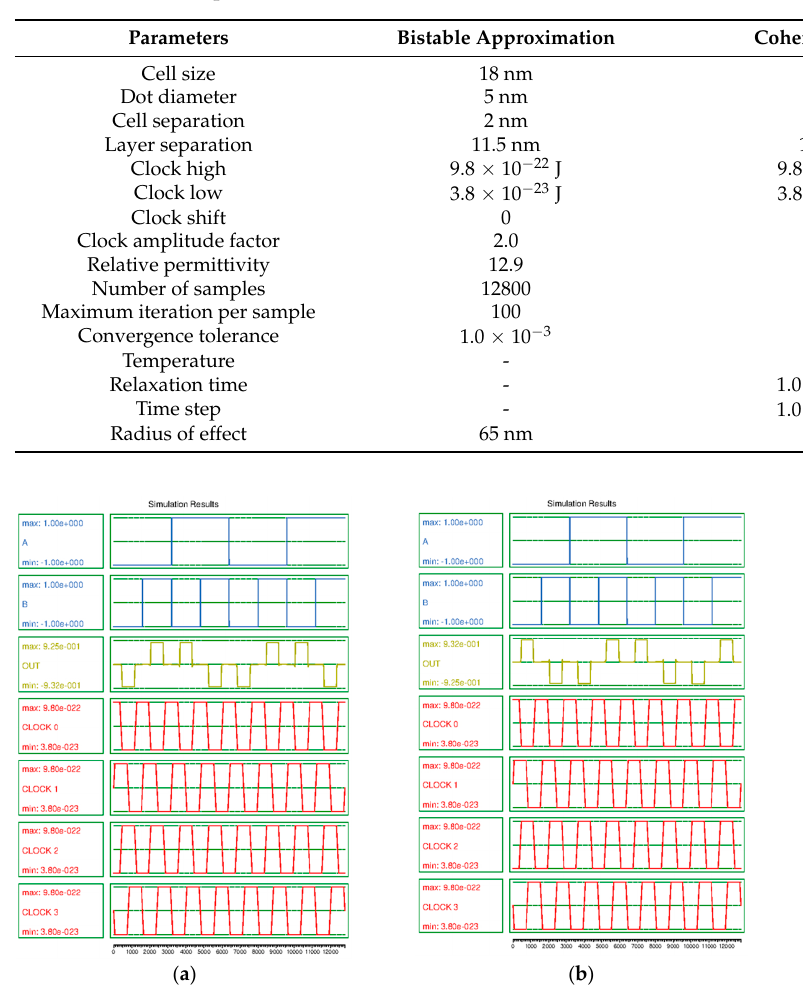
Table 3. Simulation parameters.